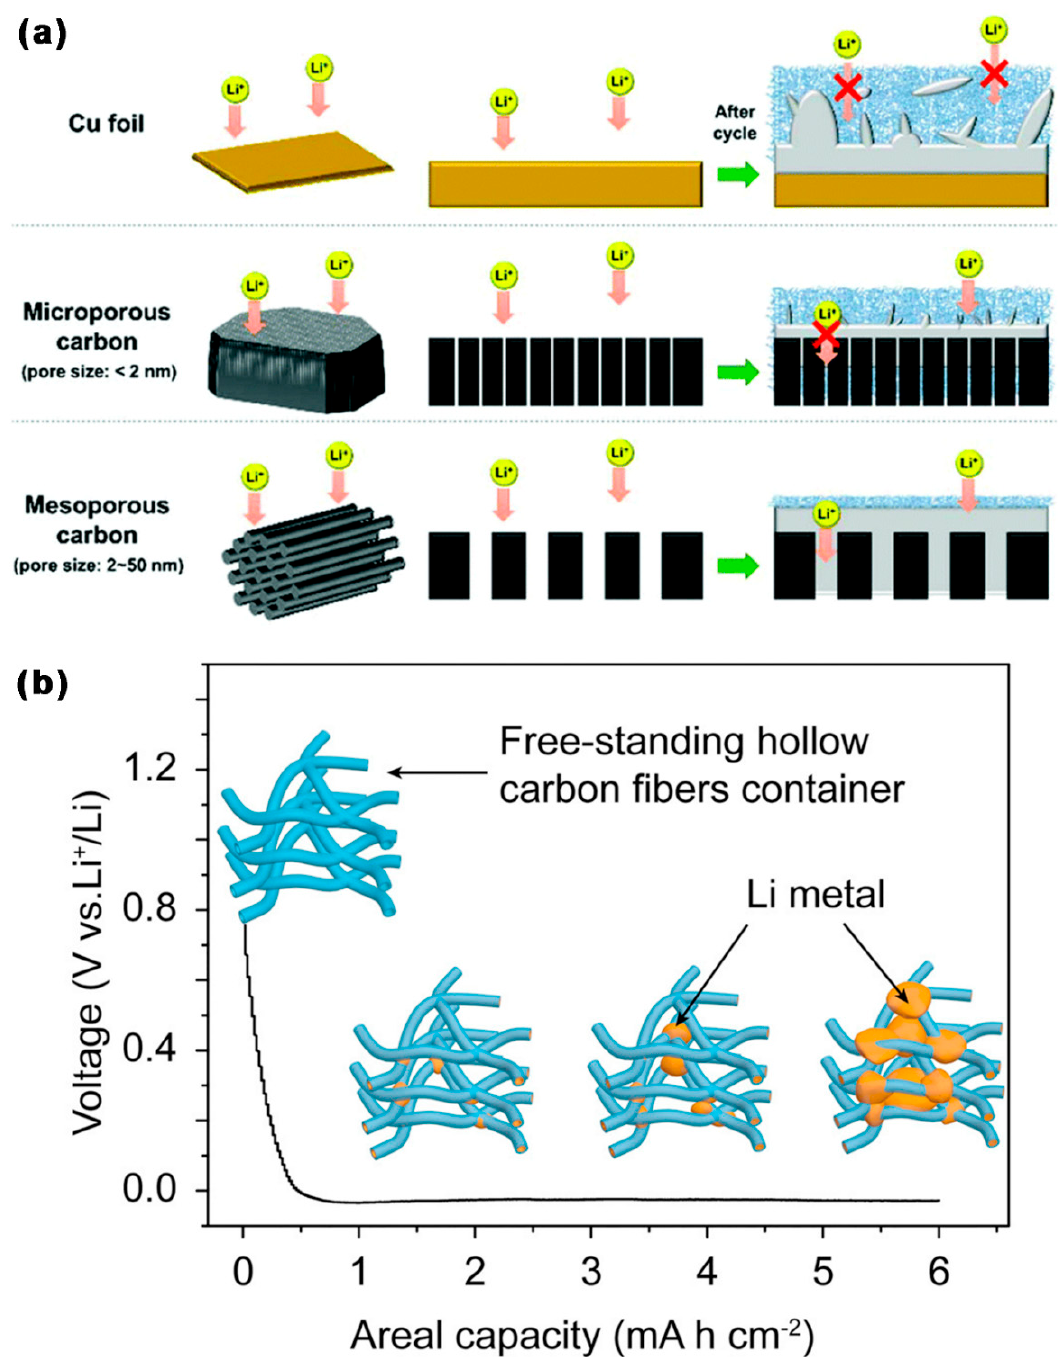
Figure 8. Schematic diagram of Li plating on ( a ) CMK-3 [85], ( b ) voltage profile of the lithium plating process and the corresponding schematic diagram [86].